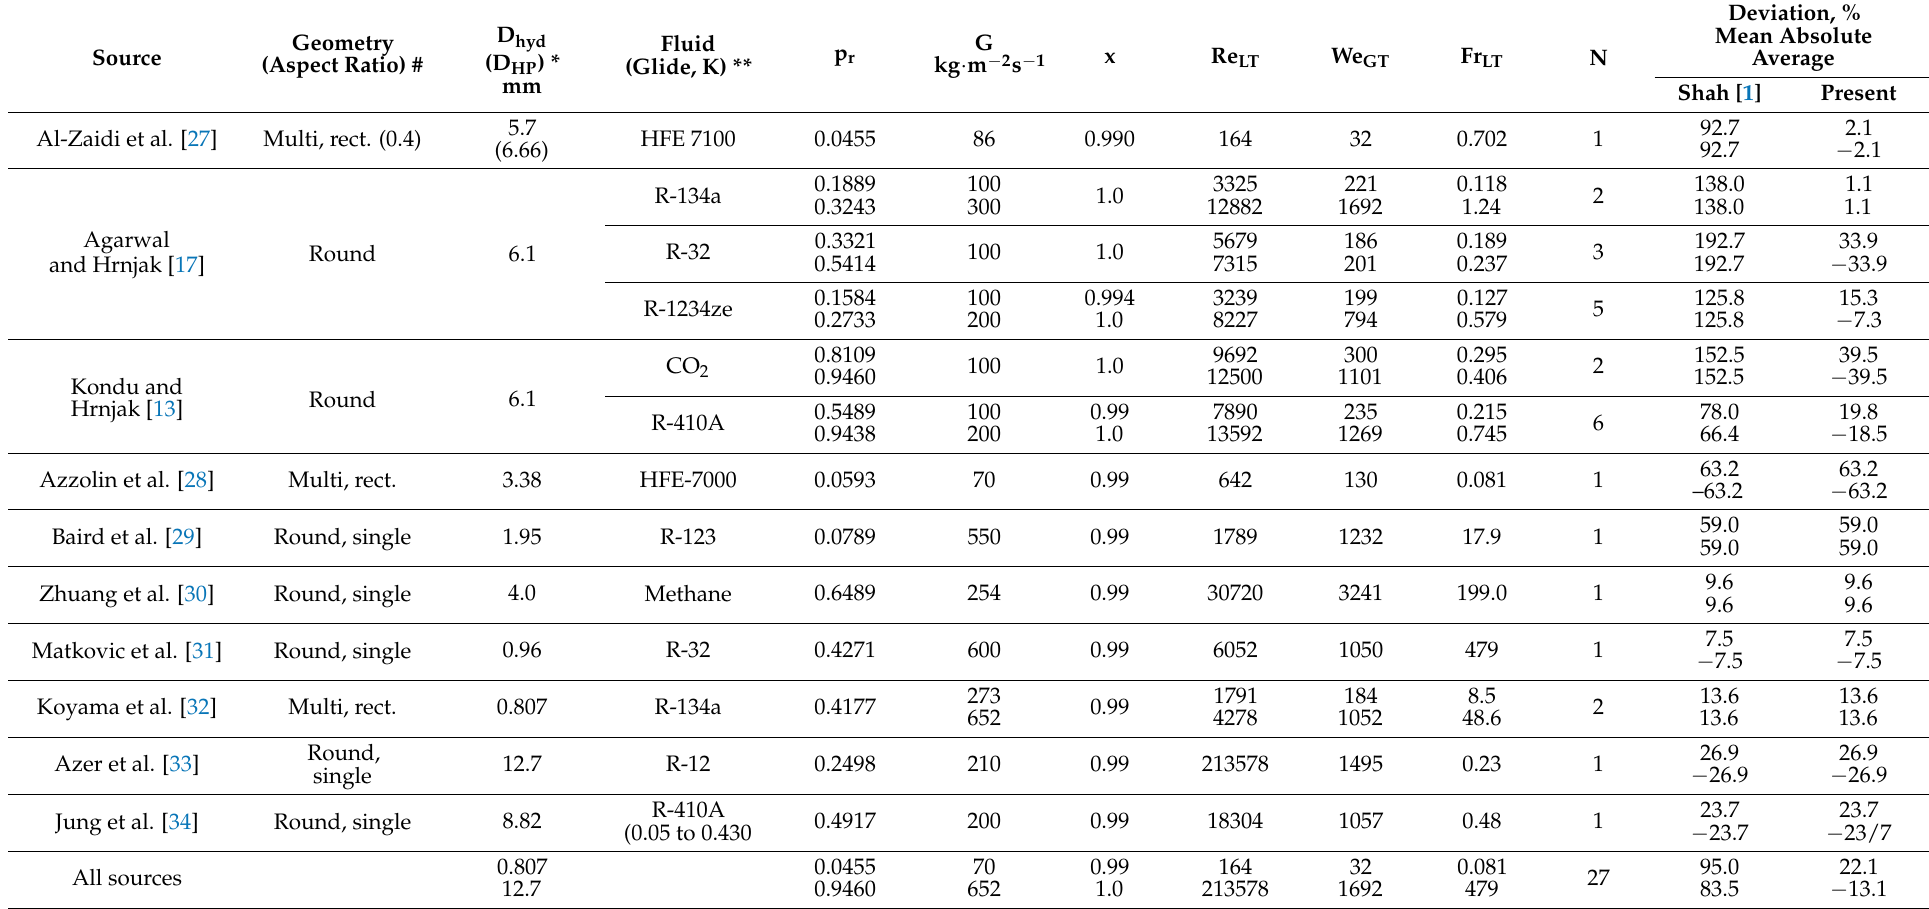
Table 1. Range of new data analyzed and deviations of the present and Shah [1] correlations. All channels were